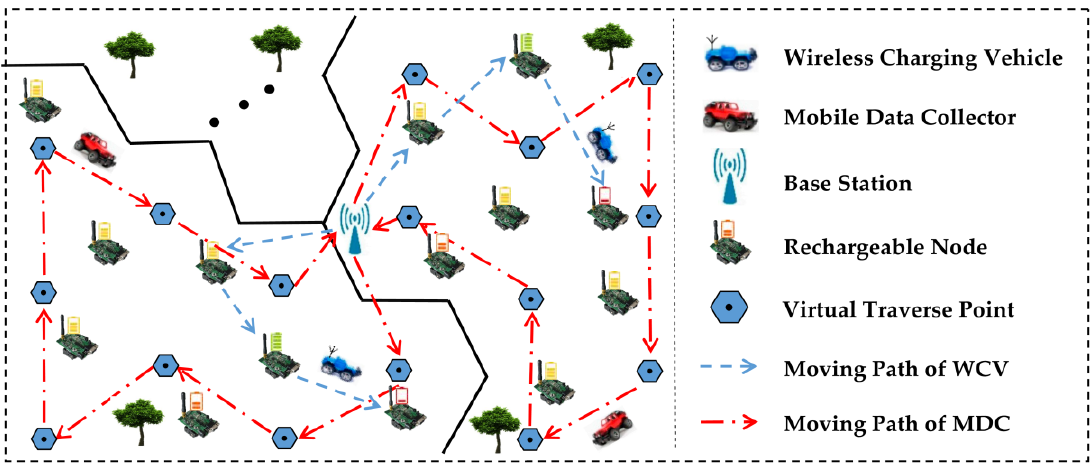
Figure 6. Network architecture.